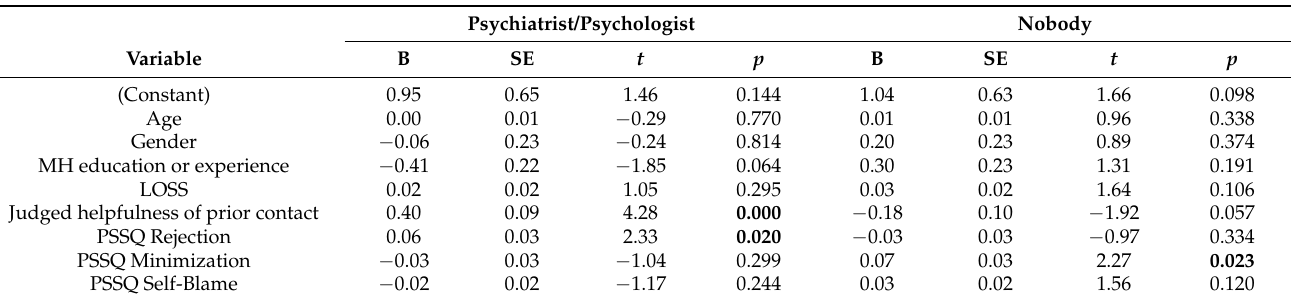
Table 6. Summary of hierarchical regression analyses for those who had prior contact with mental health professionals for each source of help as the outcome